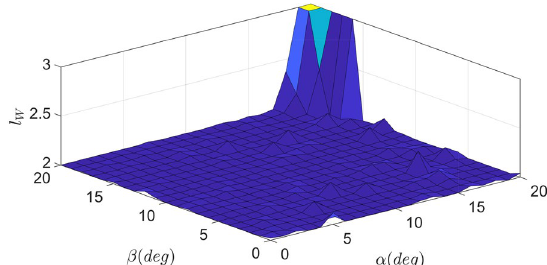
Fig. 21 Wang “ l W ” parameter